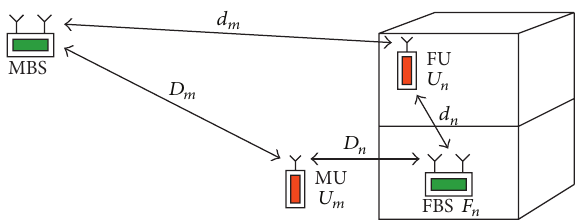
Figure 1: The system model of 2-tier heterogenous femtocell net-